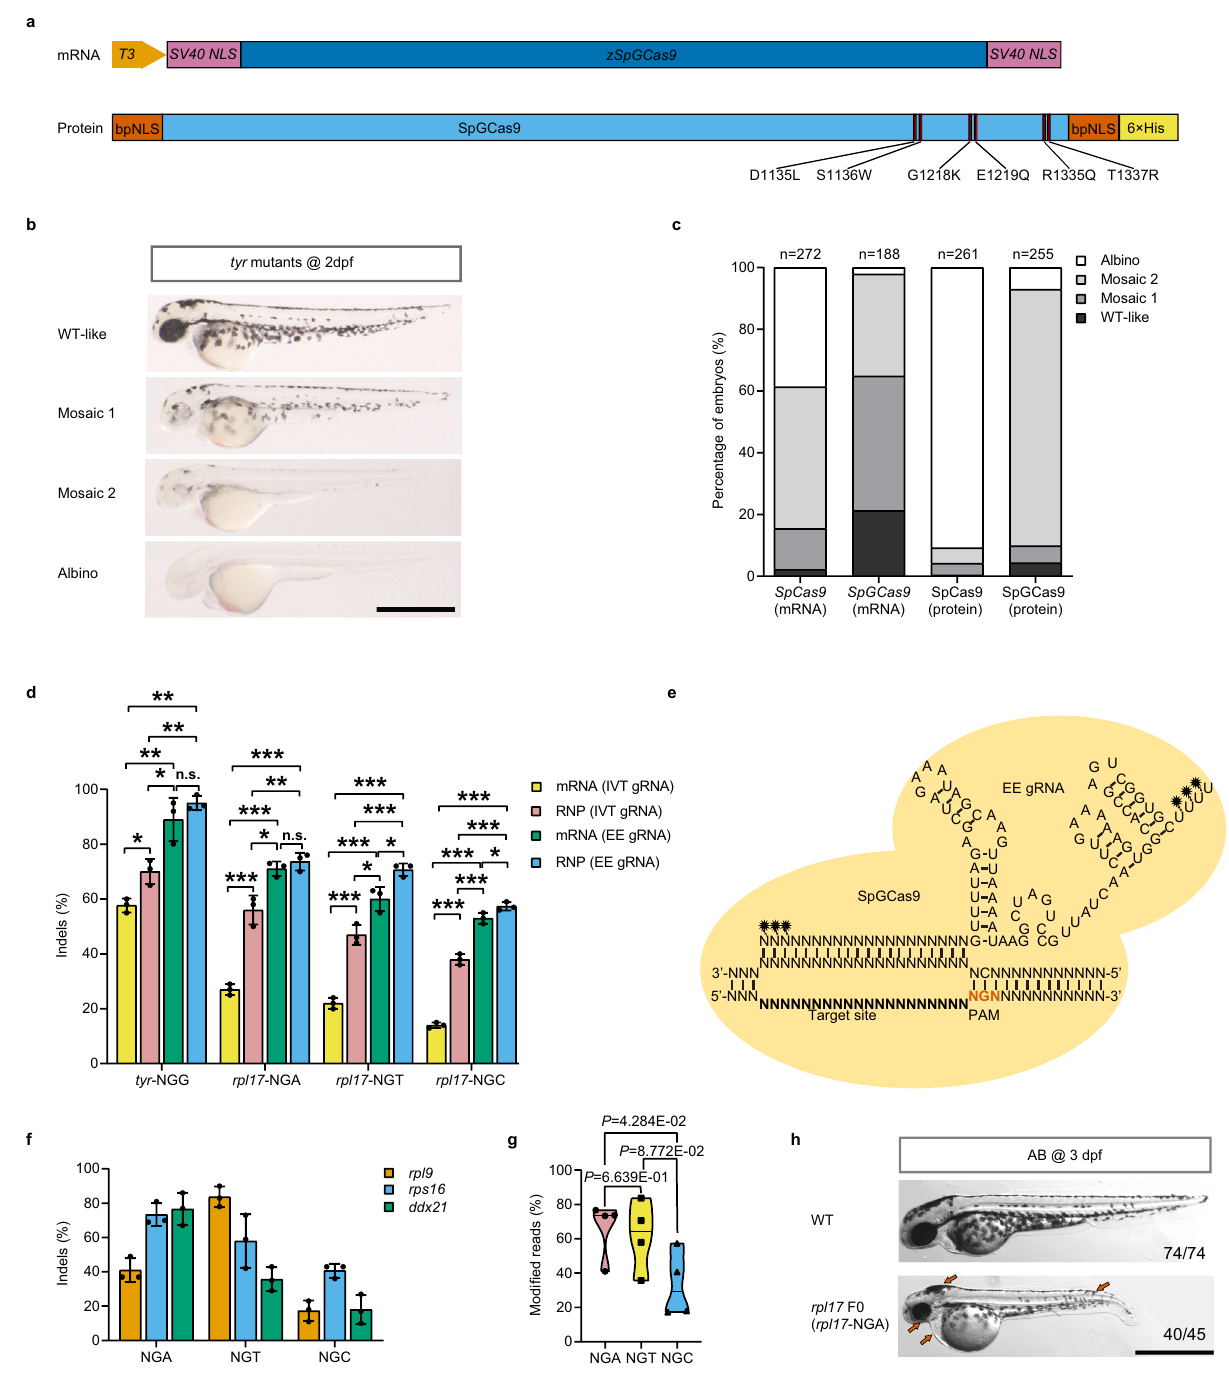
results indicate that, after optimization, SpG is an ef fi cient and broadly targeting nuclease across NGN PAM sites in zebra fi